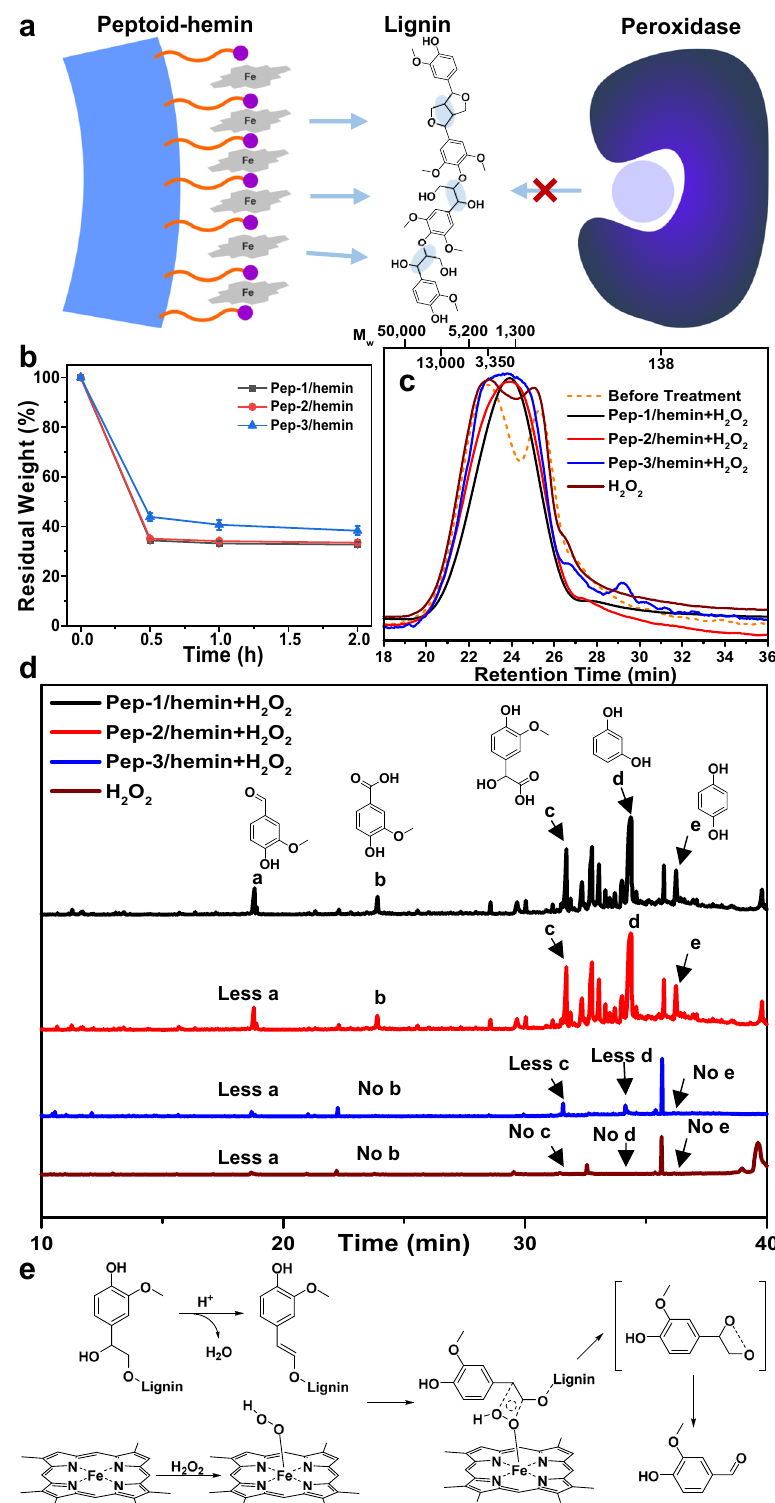
Fig. 6 Lignin depolymerization by Pep/hemin nanomaterial catalysts. a Schematic representation showing the multiple active sites on peptoid-hemin nanomaterial interacting with lignin (left) compared to a single-active site on lignin peroxidase (right). b Residual weight percent of EOL after treated with Pep-1/hemin , Pep-2/hemin , and Pep-3/hemin for 30 min, 1 h, and 2 h. The error bar represents the standard deviation of three measurements. c GPC pro fi le of EOL samples before treatment, after treatment with Pep-1/hemin , Pep-2/hemin , or Pep-3/hemin in the presence of H 2 O 2 , after treatment only with H 2 O 2 . d GC-MS results of ethyl acetate extractable products, including fi ve phenolic compounds a – e, from lodgepole pine lignin treated with or without peptoid/hemin catalysts at 60 °C under acidic solution (pH~4) in the presence of H 2 O 2 . e Proposed reaction mechanism of oxidative depolymerization of lignin with the heme center in peptoid/hemin nanomaterial